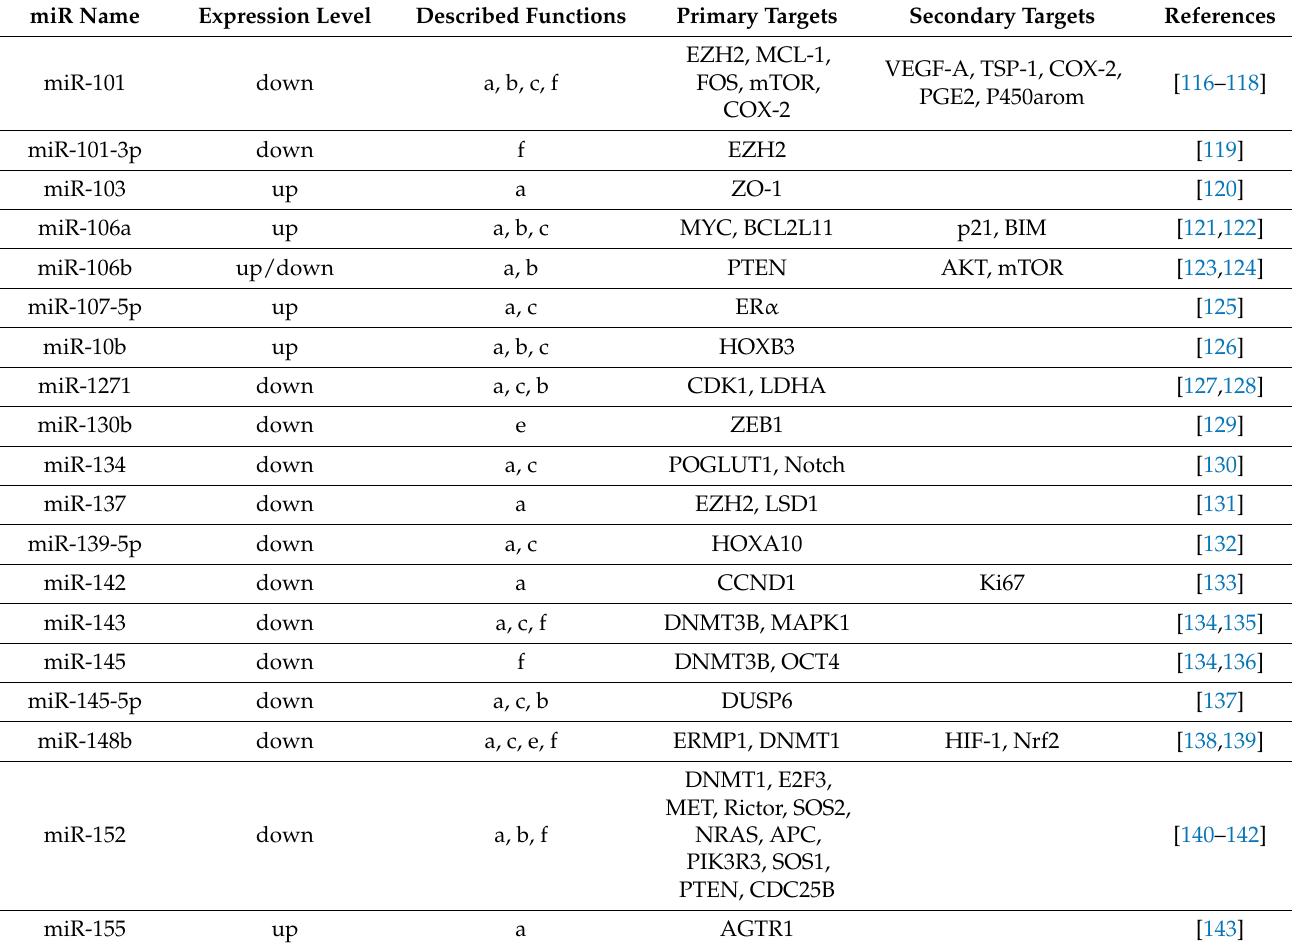
Table 2. A summary of sncRNAs that play a role in EC pathogenesis and for which a functional characterization is